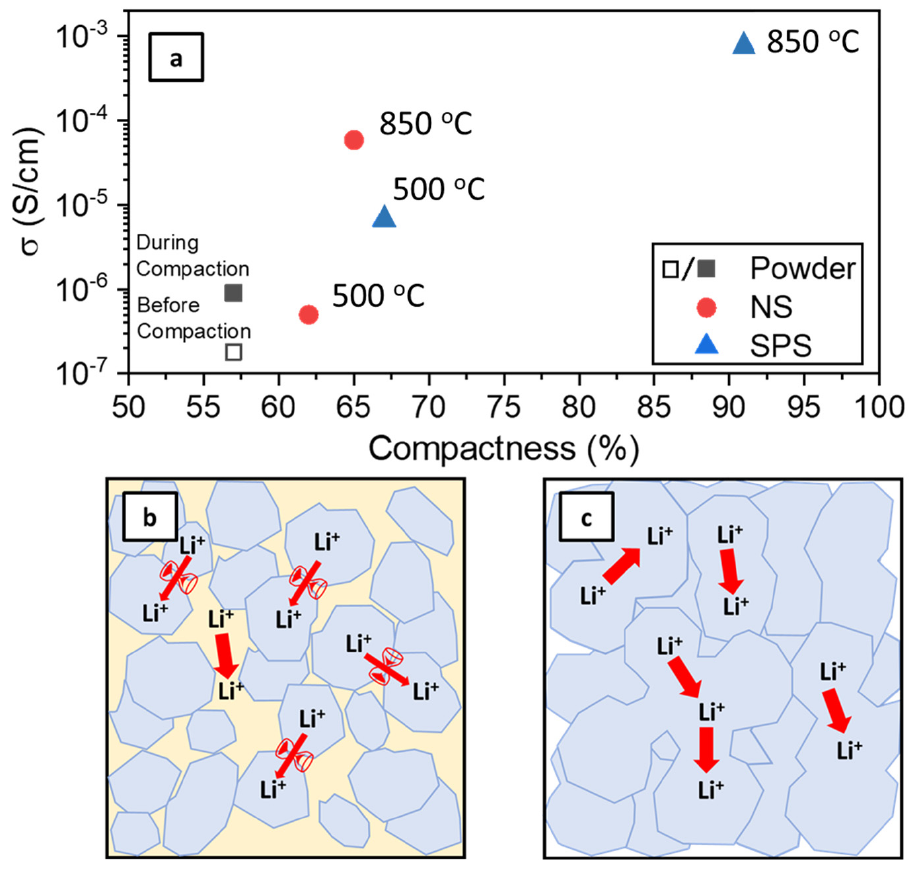
Figure 2. ( a ) Evolution of the total ionic conductivities of LATP materials at 30 °C as a function of their compactness. ( b ) Schematic representation of the grain boundaries of LATP powders simply pressed and ( c ) sintered with improved grain boundary contacts.